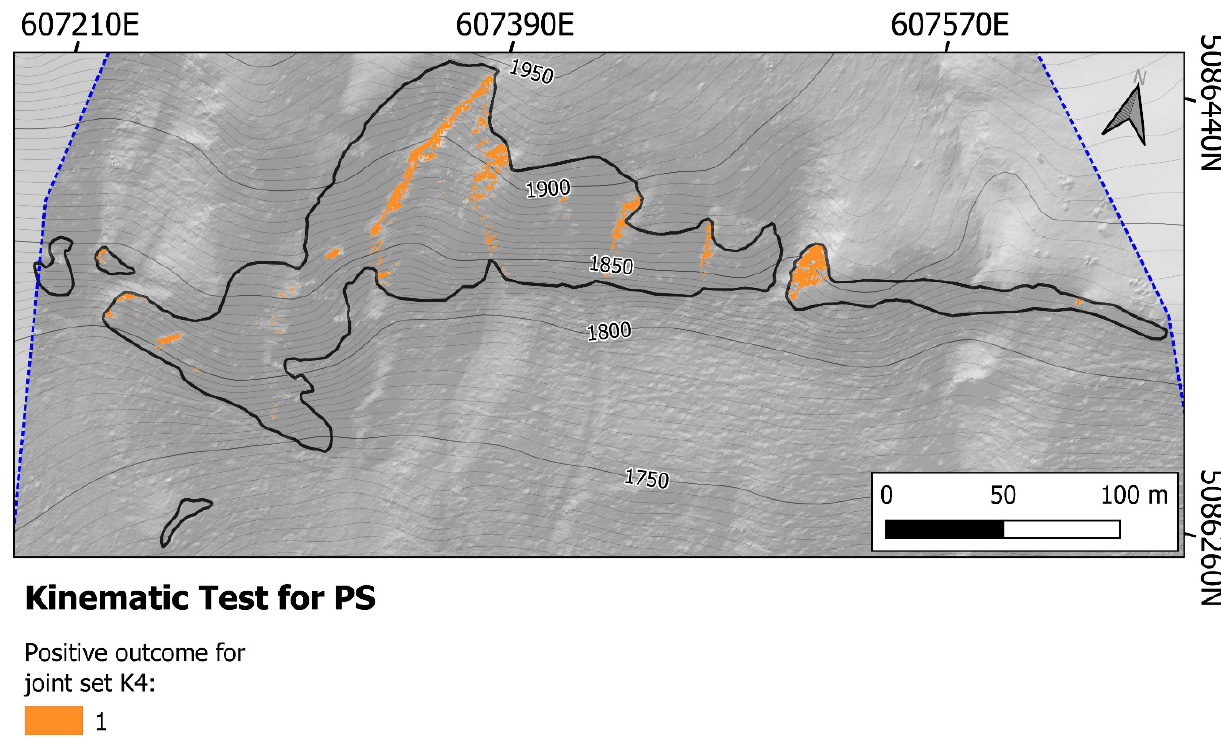
Figure A3. Image of the partial output file showing the kinematic test for PS performed considering only joint set K3.